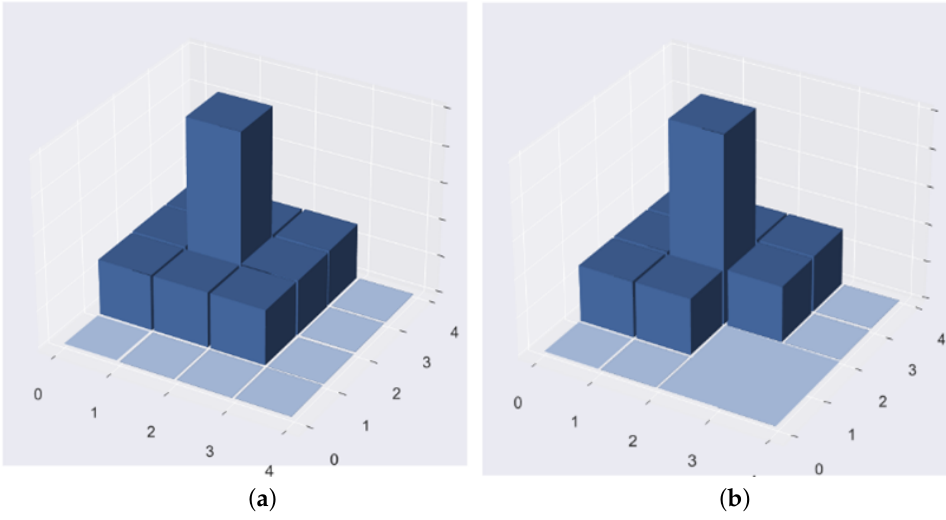
Figure 2. ( a ) Complete pheromone diffusion. ( b ) Incomplete pheromone